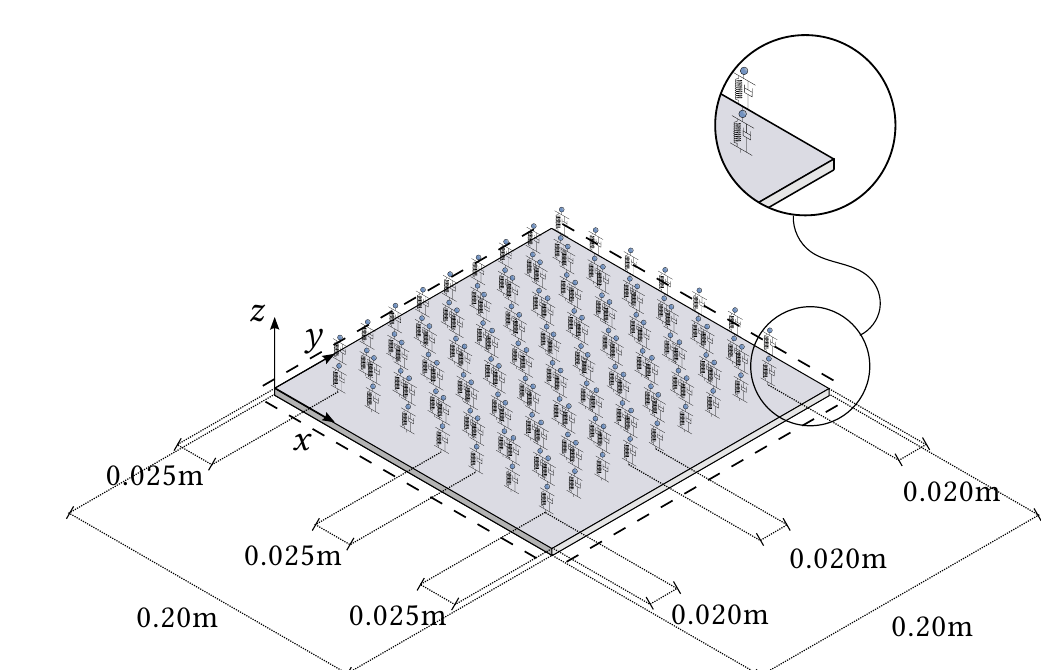
Figure 3. Simply supported LRMP with mass–spring–damper subsystems modelling 2-DOF resonators.